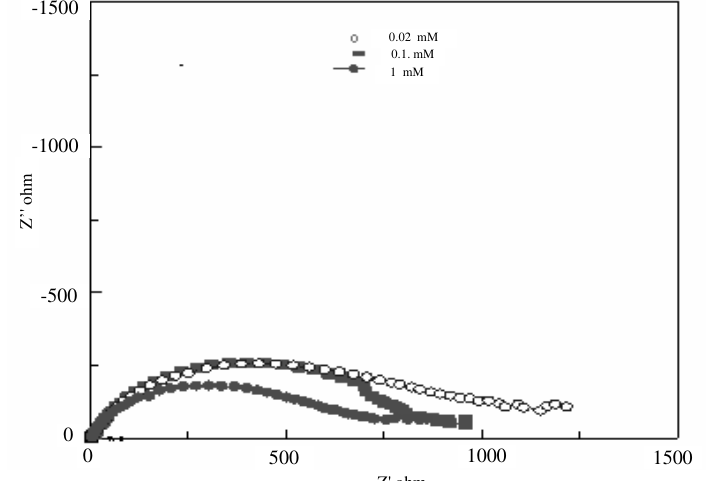
Figure 5. Nyquist diagram for mild steel in 1 M H inhibitor